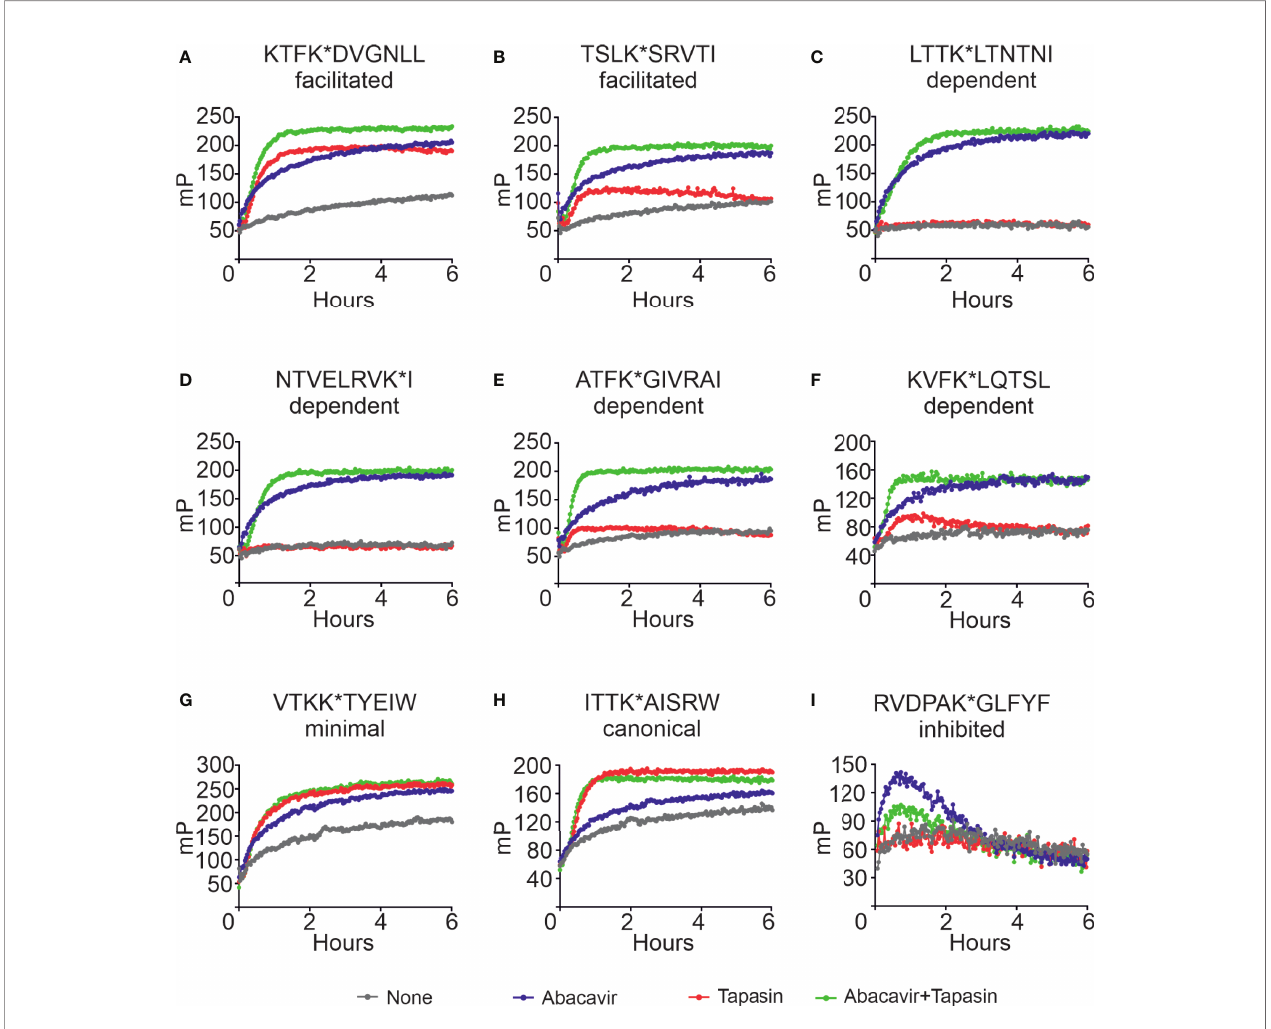
FIGURE 5 | Abacavir diversi fi es the HLA-B*57:01 peptide repertoire by enhancing the loading of speci fi c peptides. Conditional ligand loaded HLA-B*57:01fos molecules were UV exposed before the binding of the indicated peptide ( A = KTFK*DVGNLL, B = TSLK*SRVTI, C = LTTK*LTNTNI, D = NTVELRVK*I, E = ATFK*GIVRAI, F = KVFK*LQTSL, G = VTKK*TYEIW, H = ITTK*AISRW, I = RVDPAK*GLFYF) was followed at 25°C in the presence or absence of excess abacavir and/or monomeric or ERp57 C60A conjugated tapasin-jun. Binding of fl uorescent peptide is reported in millipolarisation units (mP). Unbound fl uorescent peptide is assumed to have an mP level of 50. Data shown are representative of triplicate or greater experiments. The extent that tapasin, abacavir, or the combination of both enhanced the binding of fl uorescent peptides to HLA-B*57:01fos molecules in the replicate experiments is presented in Figure 6 . Colour coding is as follows: grey — peptide alone, blue — abacavir, red — tapasin, green — abacavir +